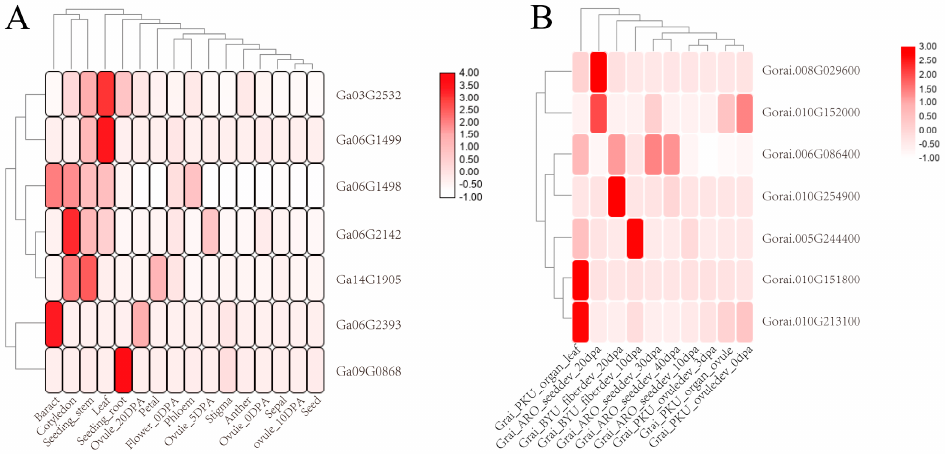
Figure 4. Expression heatmap of PPO genes of the diploid cotton species in different organs at the diverse stages of development. Note: ( A ) represents the expression situation of PPO genes of G. arboreum in different organs at the diverse stages of development, and ( B ) represents the expression situation of PPO genes of G. raimondii in different organs at the diverse stages of development.